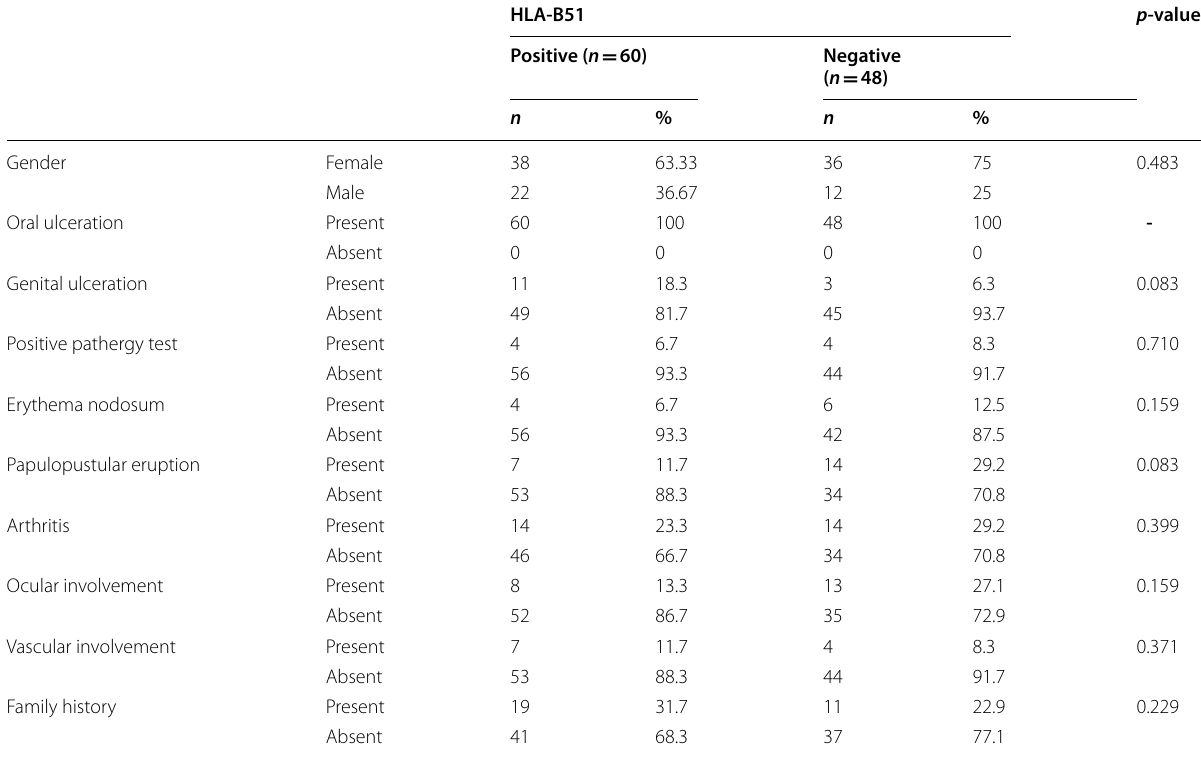
Table 3 The clinical differences between HLA-B51 positive and negative